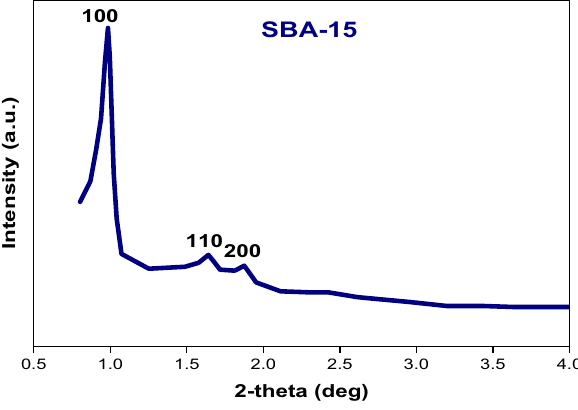
Figure 2: XRD small angle pattern of SBA -